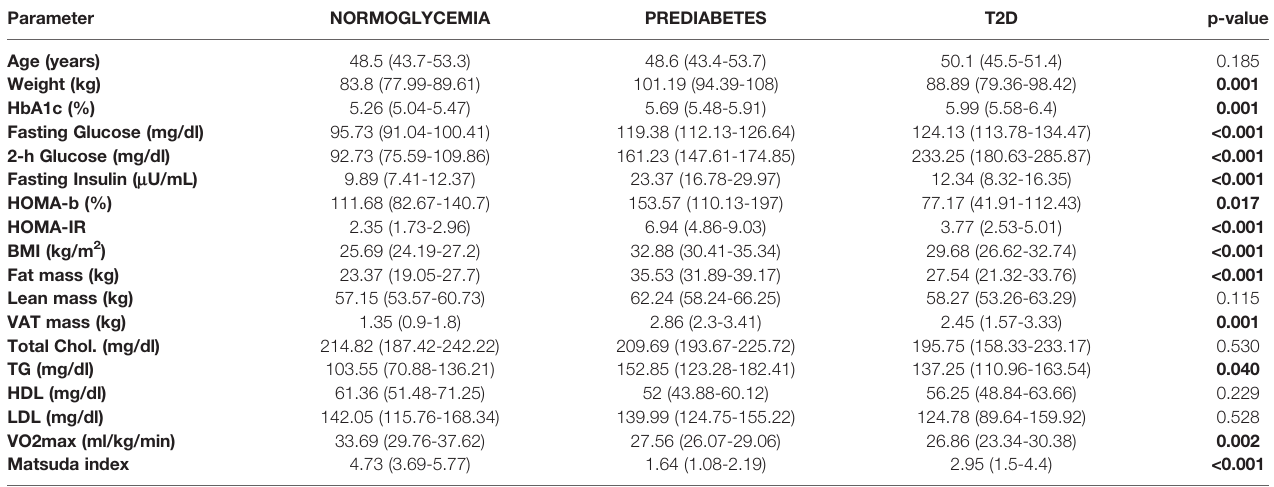
TABLE 1 | Clinical characteristic of studied groups before the initiation of the exercise intervention.